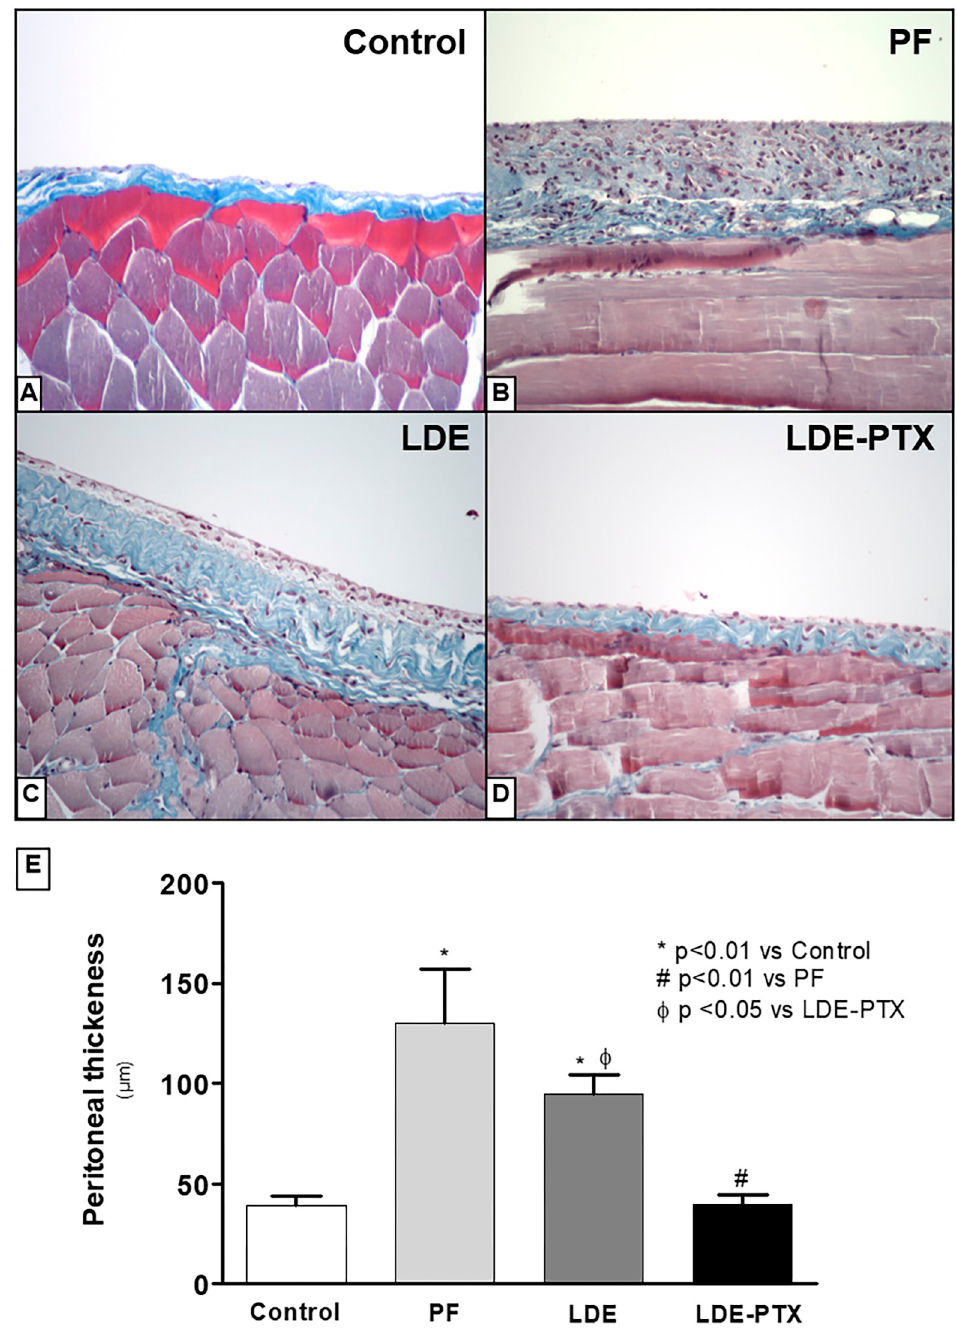
Fig 2. LDE-PXT treatment on peritoneal thickness. Representative photomicrographs of peritoneal membrane samples stained with Masson’s trichrome (x200). (A) The Control group (n = 5) showed a normal peritoneum without any morphological changes. (B) The PF group (n = 5) and (C) the LDE group (n = 8) showed a significant thickening of the peritoneal membrane. (D) LDE-PXT group (n = 8) showed prominent preservation of the peritoneal membrane without fibrosis development and also preserved the monolayer structure at day 15, nearly to the Control group as demonstrated by quantitative analysis (E) . � p < 0.01 vs Control; # p < 0.01 vs PF; F p < 0.05 vs LDE-PTX.